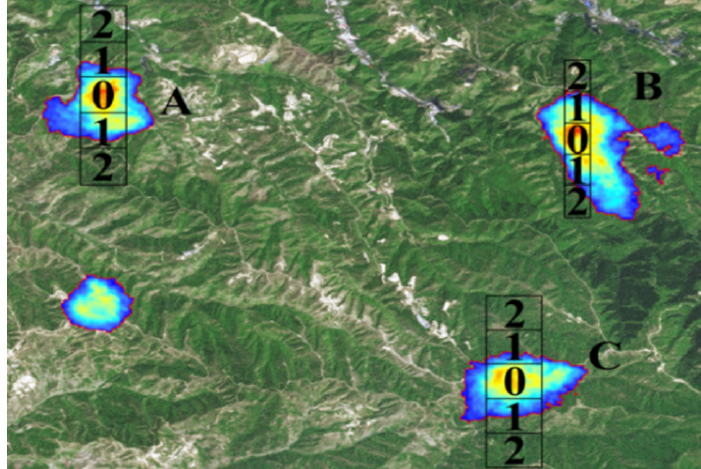
Figure 4. Study partitions of A, B, and C. Table 3. Relative change rate of NDVI in different zones from 2013 to 2020. Relative Change